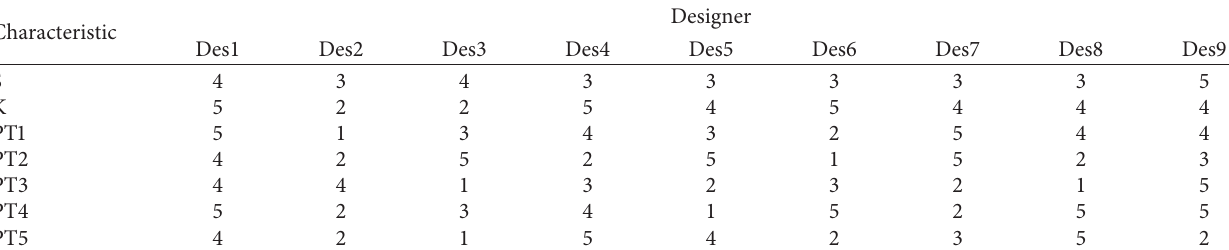
Table 5: Designers’ performance as estimated by the DPE. Designer